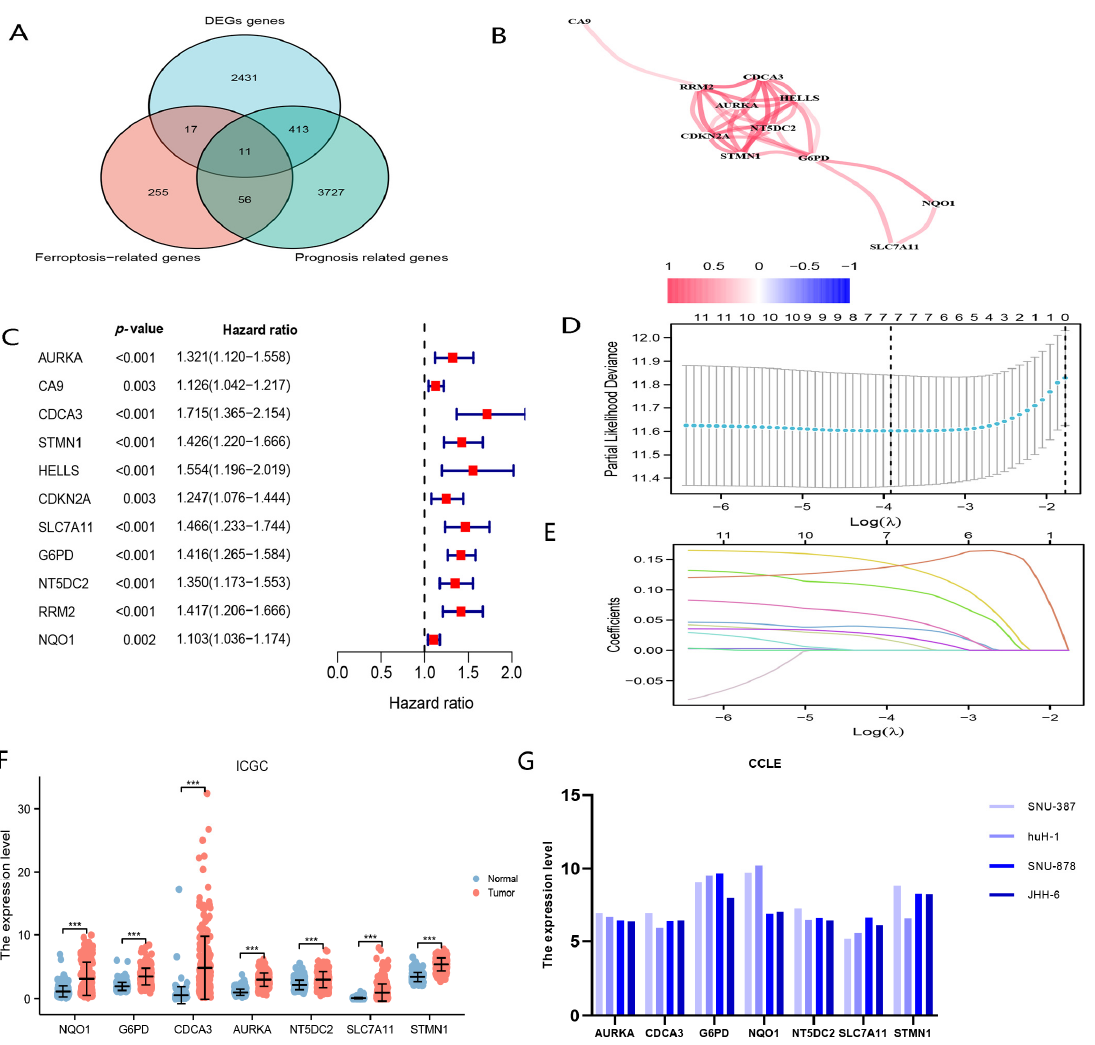
Figure 2. The procession before constructing nFRGs. ( A ) Screening candidate genes. ( B ) The correlation network of candidate genes. ( C ) Univariate Cox analyses of candidate genes. ( D ) LASSO coefficient profiles. ( E ) Candidate ferroptosis-related genes were filtered by the LASSO algorithm. ( F ) Verification of the expression level of genes consisting of nFRGs in ICGC. ( G ) Verification of the expression level of genes consisting of nFRGs in CCLE. (*** representing p < 0.001). nFRGs risk score = [AURKA × (0.01584)] + [CDCA3 × (0.03753)] + [STMN1 × (0.10271)] + [SLC7A11 × (0.1415856)] + [G6PD × (0.13851)]] + [NT5DC2 × (0.05450)] + [NQO1 ×